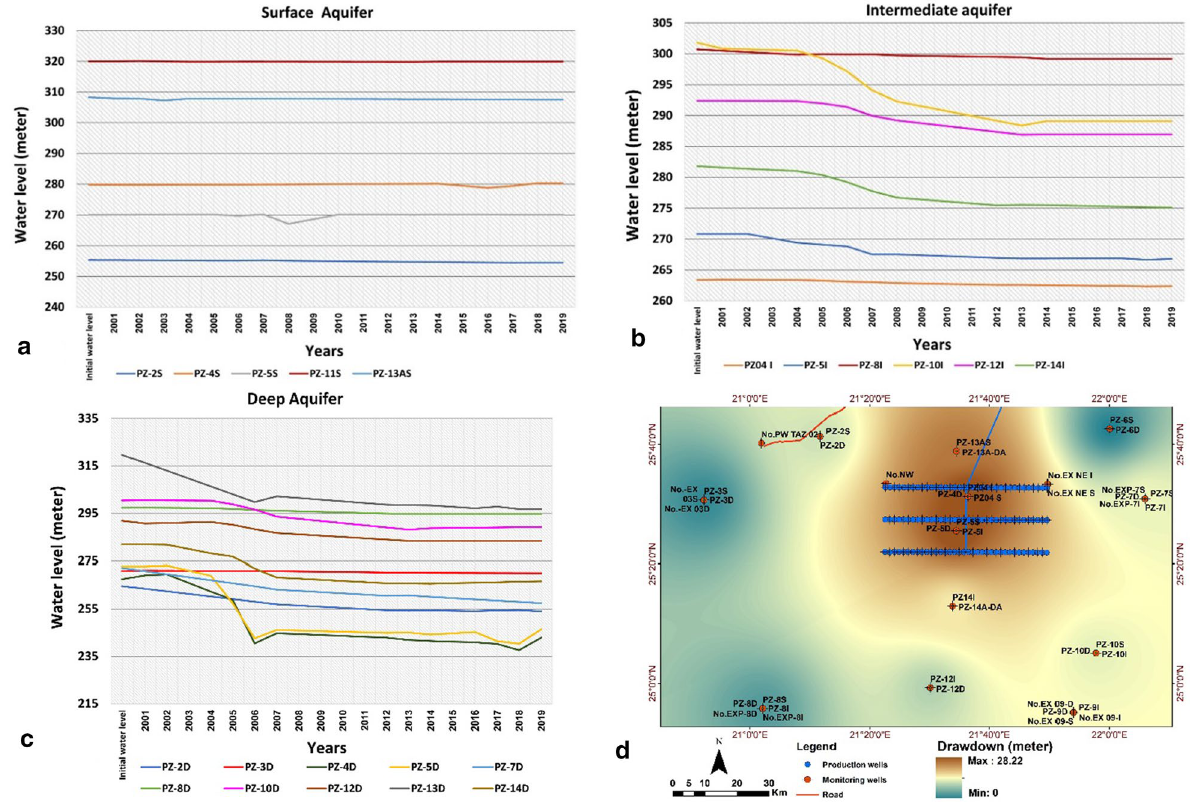
Fig. 7 Water level 2001–2019 for the three aquifers ( a , b , and c ), drawdown of the deep aquifer ( d )